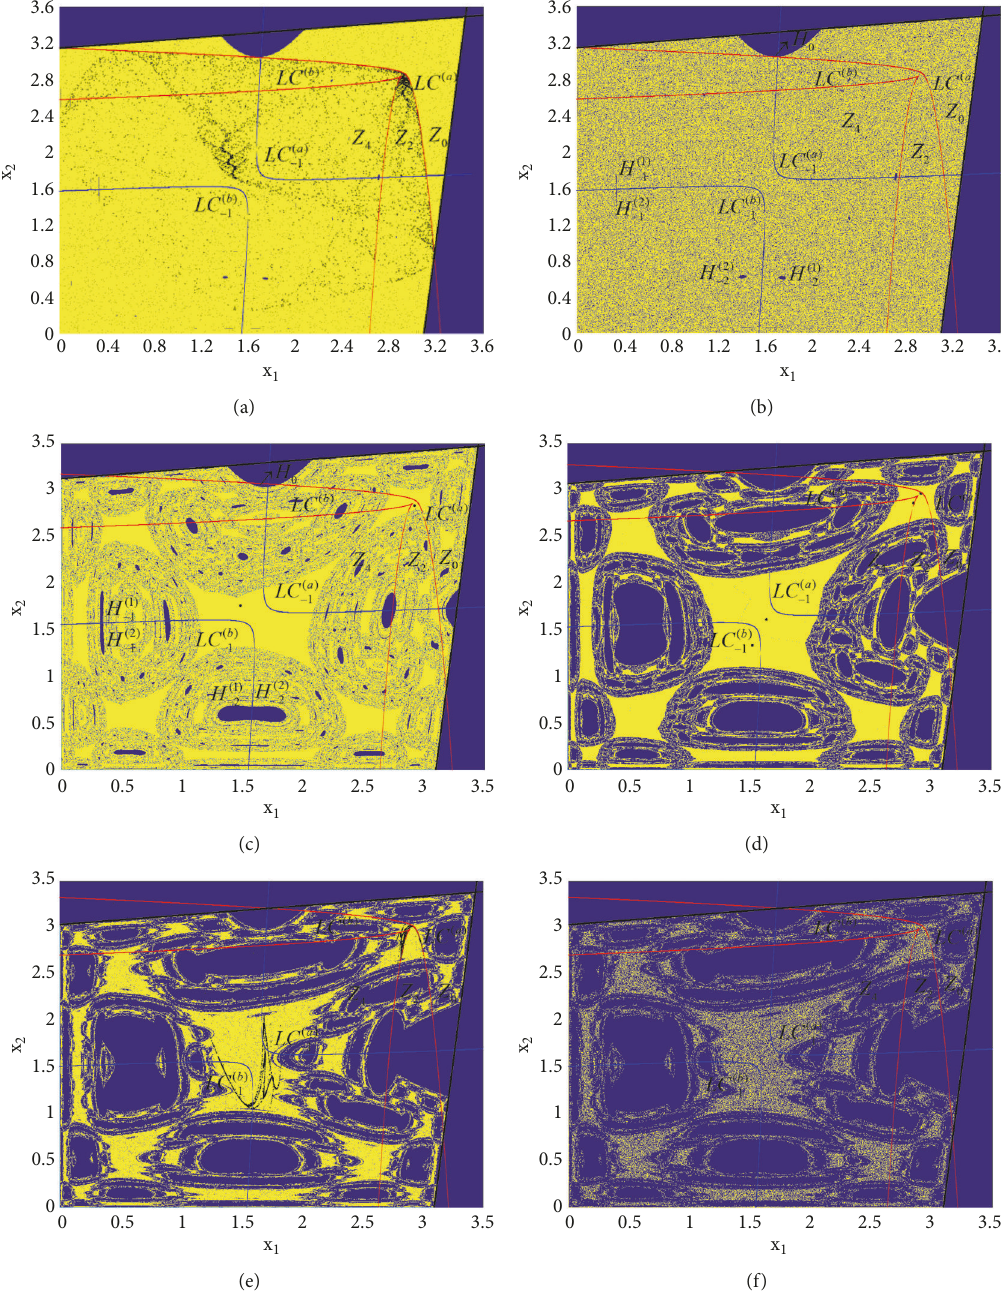
Figure 14: The corresponding basin of attraction for different values of 𝛼 2 , and the parameters are fixed as 𝑎 = 1.95 , 𝑏 = 0.044 , 𝑐 = 1.58 , 𝛽 = 0.9 , 𝛾 = 0.77 , and 𝛼 = 1.572 . (a) 𝛼 = 1.4893 : a chaotic attractor and its attracting domain. (b) When the parameter 𝛼 1 2